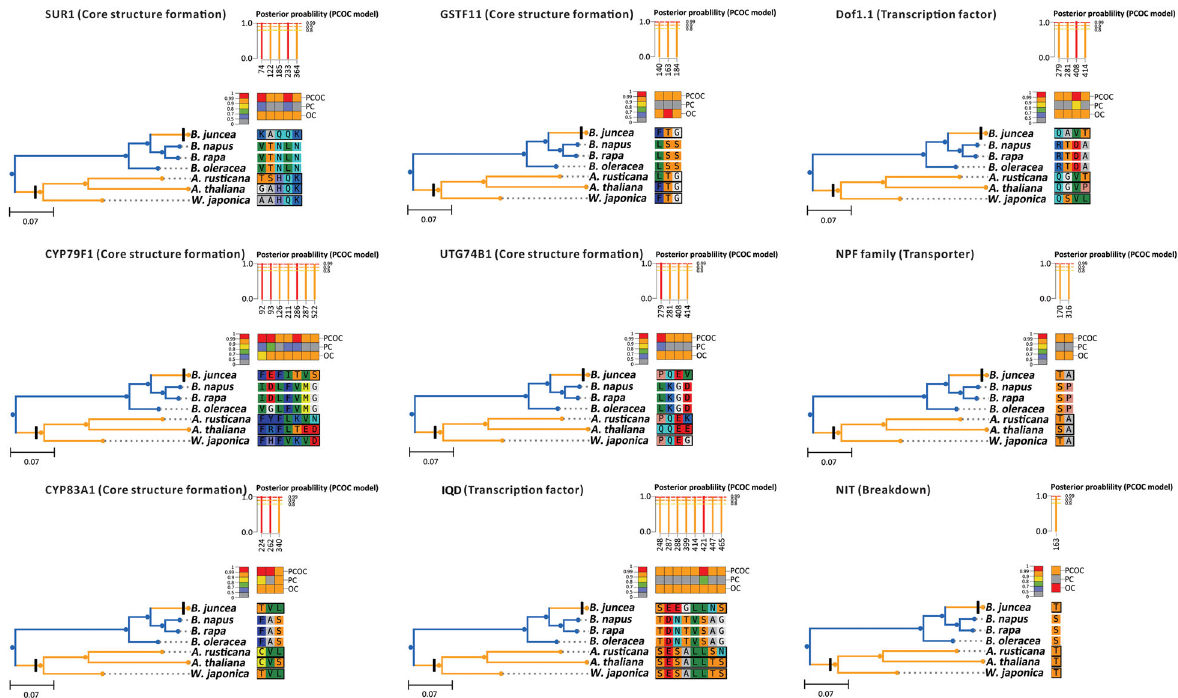
Fig. 4 Convergent evolution analysis of genes related to GSL metabolism in Brassicaceae . Detection of convergent shifts in the SUR1, Dof1.1, and NPF protein families in Brassicaceae using the PCOC toolkit. Sites are ordered by their posterior probability (pp) of being convergent according to the PCOC model, and sites are numbered according to amino acid sequence. Posterior probabilities for the PCOC, PC, and OC models are represented by different colors: pp ≥ 0.99 (red), pp ≥ 0.9 (orange), pp ≥ 0.8 (yellow), and pp < 0.8